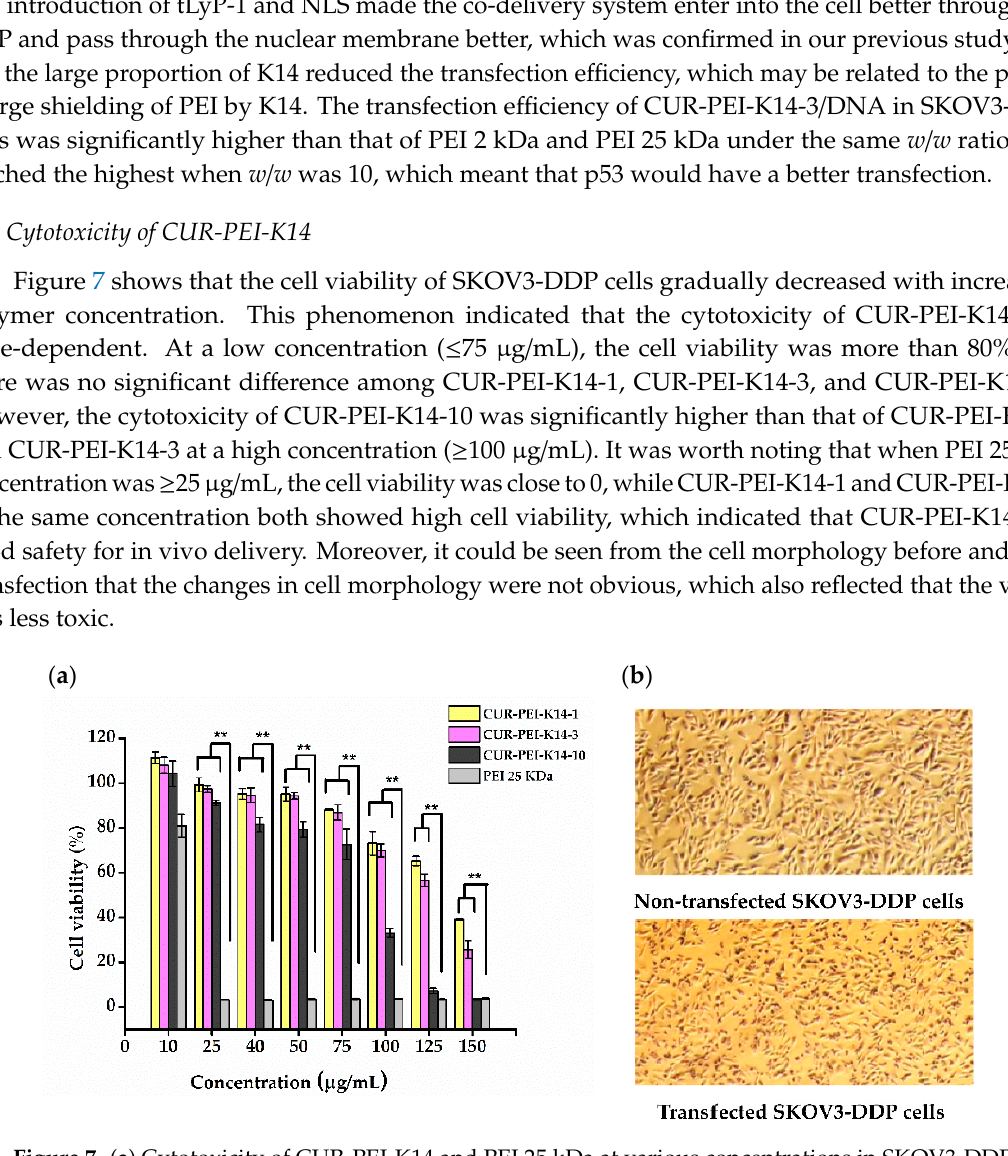
Figure 6. Transfection efficiency of ( a ) pEGFP-N2 and ( b ) pGL3-Control in SKOV3-DDP cells by different polymer/DNA complexes at w / w ratios of 5, 10, 15, 20, and 30. Each data point represents the mean ± standard deviation ( n = 3, ** P < 0.01). pEGFP-N2 is a reporter gene that can be used to